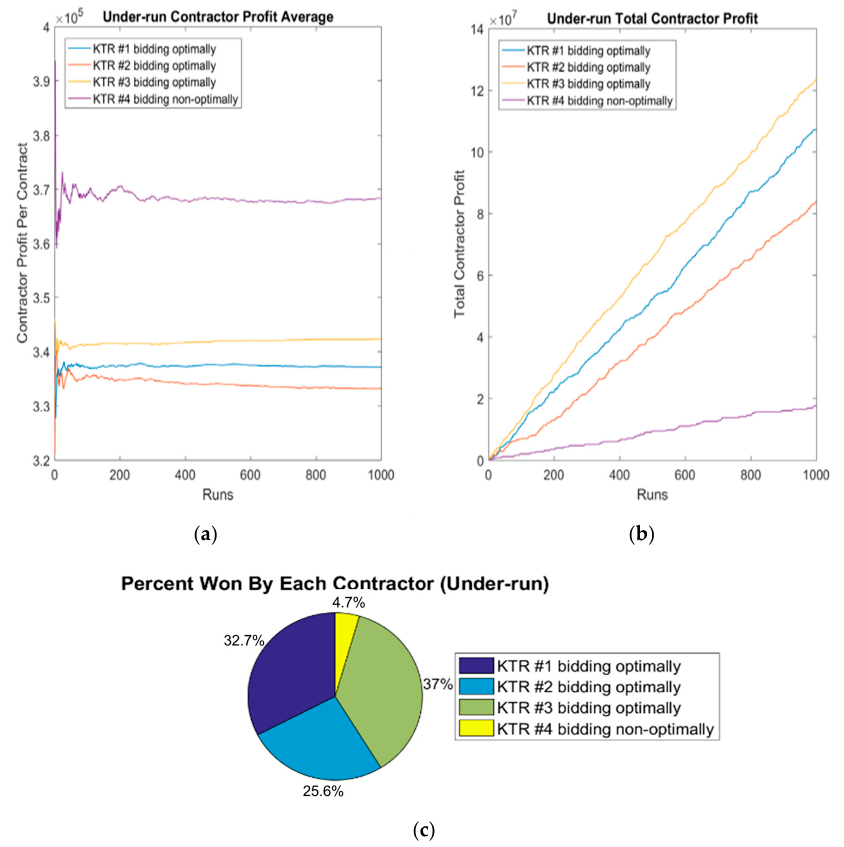
Figure 16. CPIF KTR-AWGE Simulation Results: ( a ) Profit per contract; ( b ) Total profit; ( c ) Winning percentages